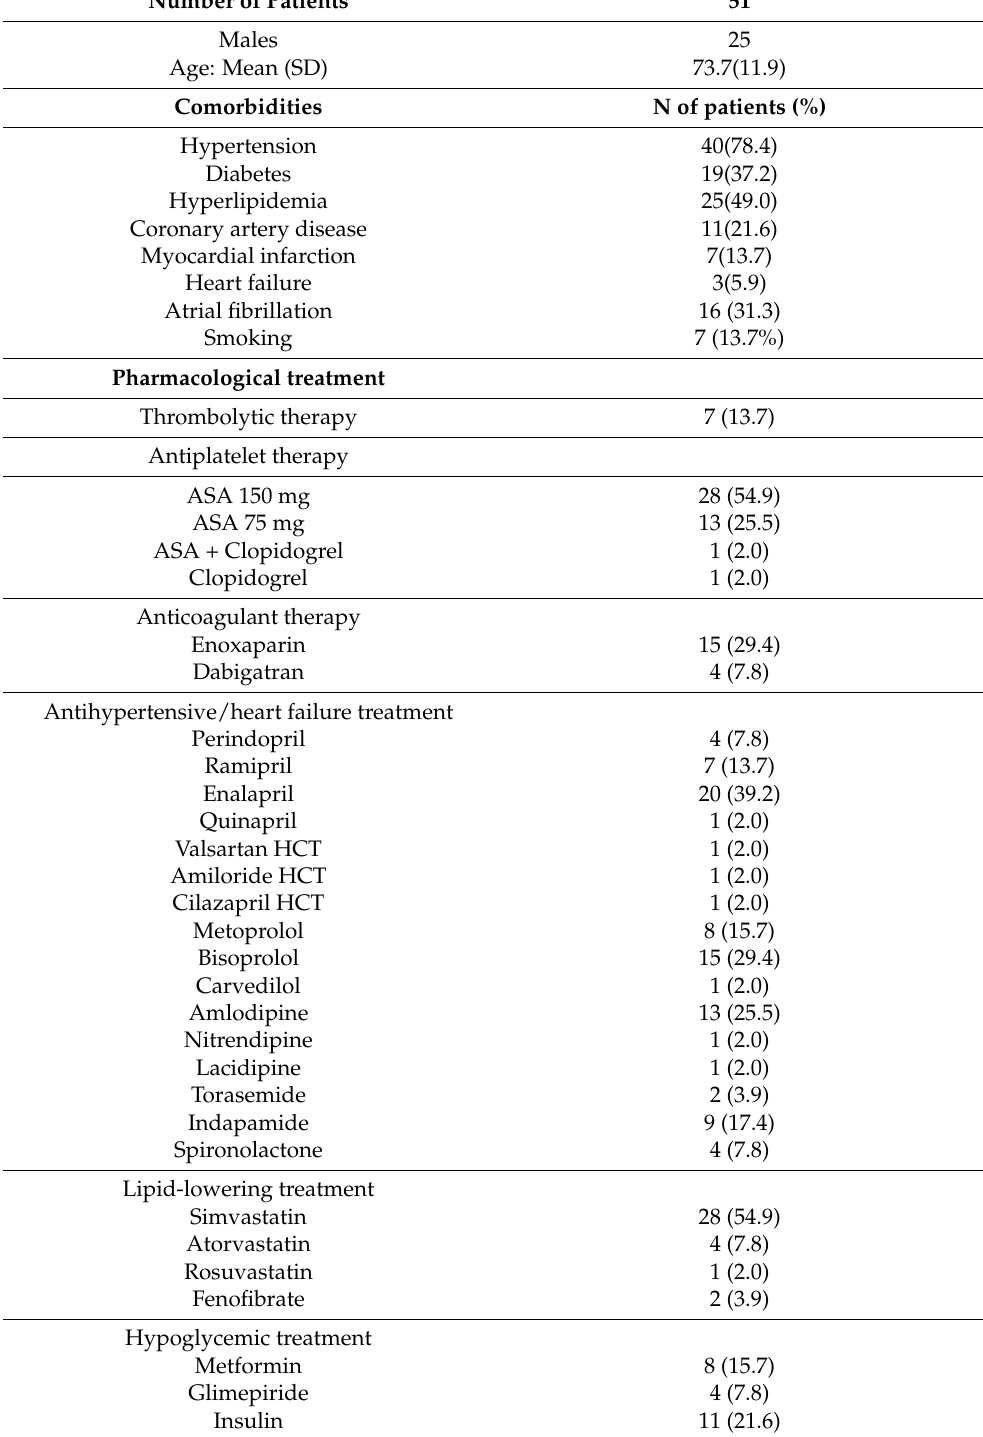
Table 1. Demographic, epidemiological and pharmacological treatment